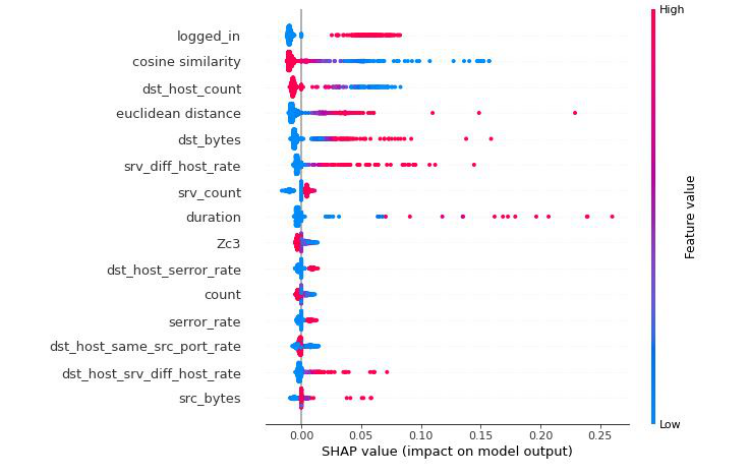
Figure 2. Summary plot of SHAP values calculated for the KDDCUP99 dataset using the EIF model of the MemAE-EIF